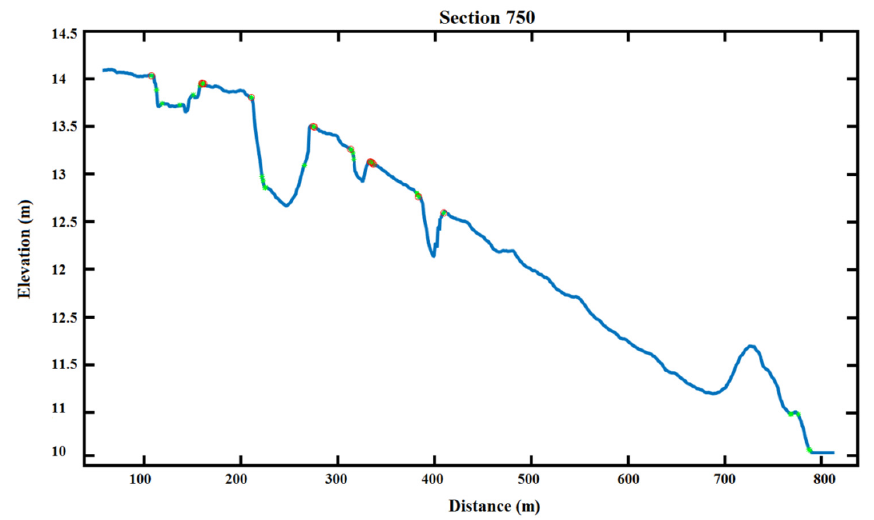
Figure 16. Height profile (cross section) along the slide direction in blue, preliminary scarp points in green, and accepted scarp points circled in red.